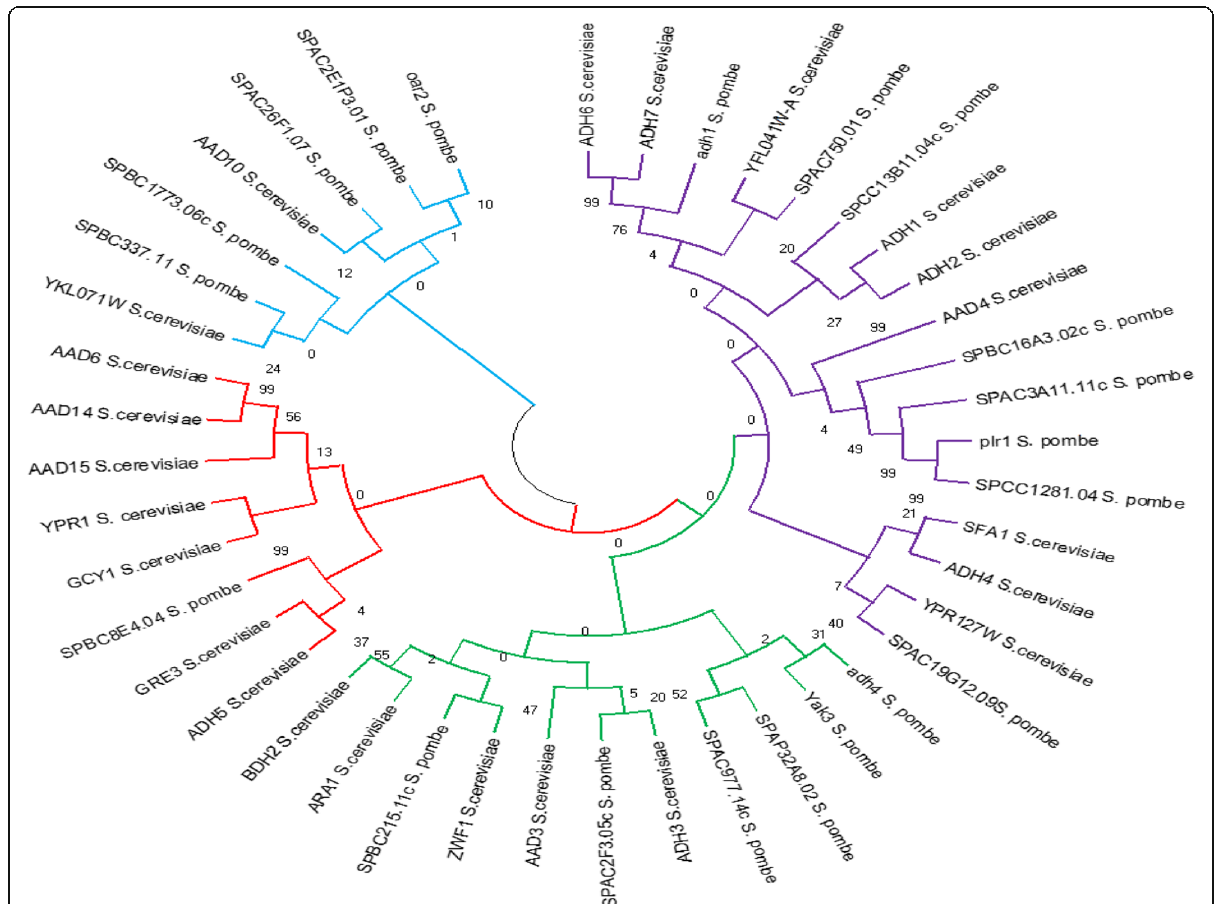
Fig. 7 Phylogenetic tree of genes encoding alcohol production sequence from S . cerevisiaea S288C and S. pombe